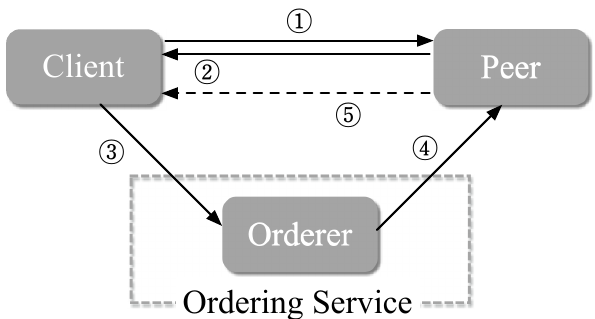
Figure 1. The Fabric component and transaction